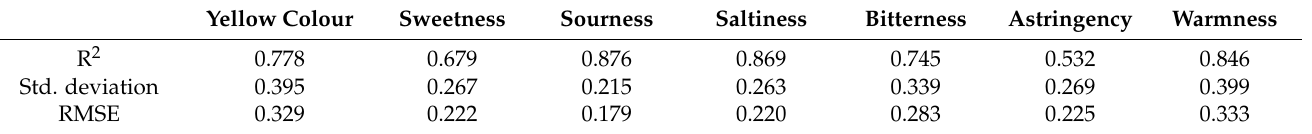
Table 3. Quality index (R 2 , standard deviation, RMSE) for PLS on visual and gustatory sensory descriptors. Yellow Colour Sweetness Sourness Saltiness Bitterness Astringency